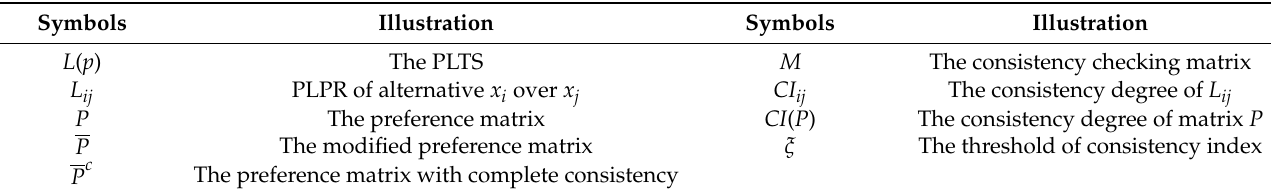
Table 1. The illustration of